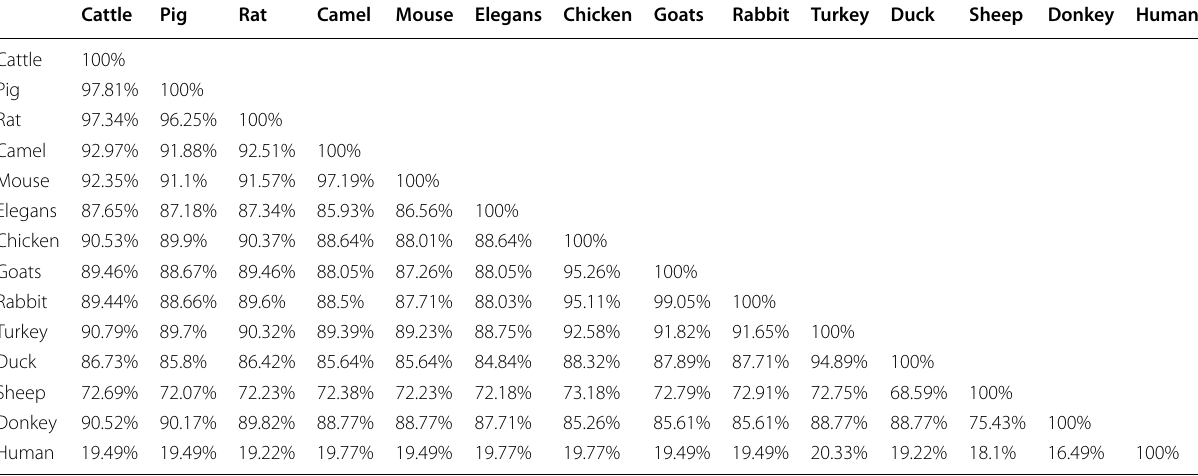
Minimum 16.49%, Maximum =